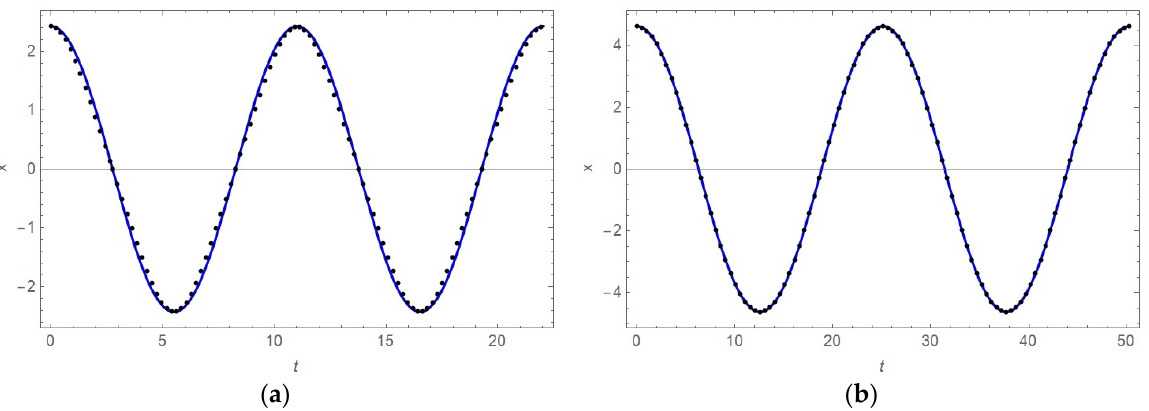
Figure 1. x-t diagrams obtained analytically (dotted line) and numerically (full line) for: ( a ) for α = 3 and ( b ) for α = 1.